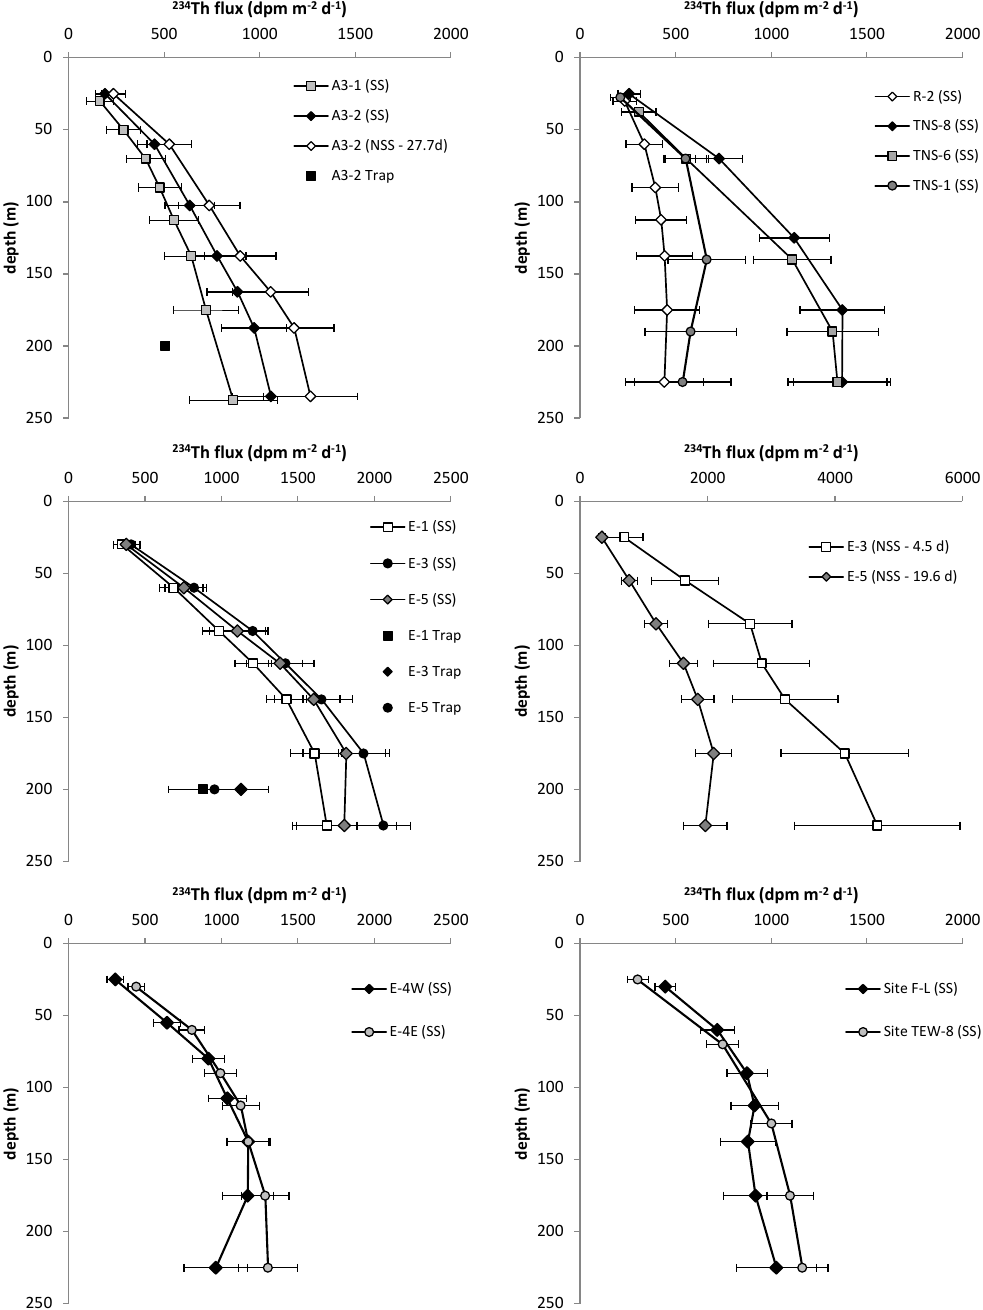
Figure 3. Depth profiles of cumulated total 234 Th export fluxes from the surface to 250m depth using steady state (SS) and non-steady state (NSS) models and comparison with 234 Th export fluxes estimated from sediment traps at